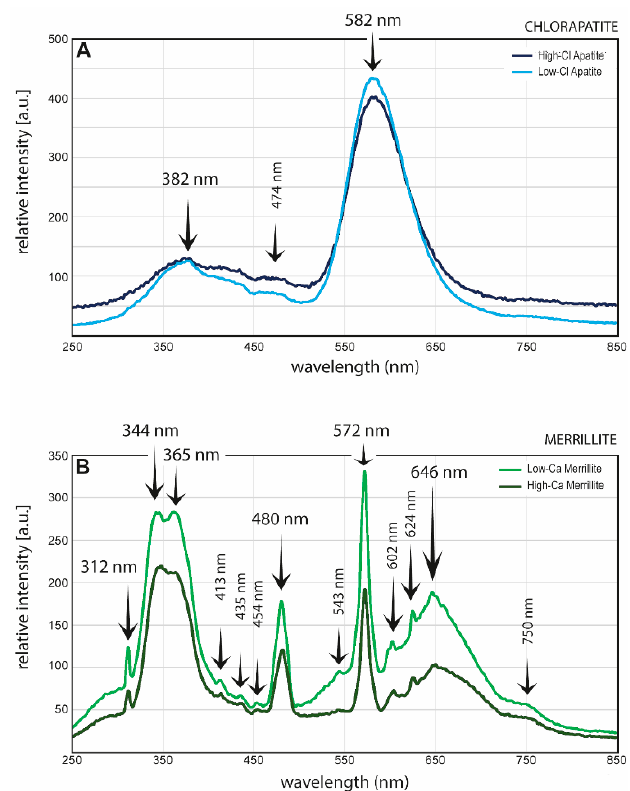
Figure 3. Cathodoluminescence spectra of the two distinct phosphates. ( A ) Chlorapatite, high and low chlorine-content types, and ( B ) merrillite, high and low calcium content.